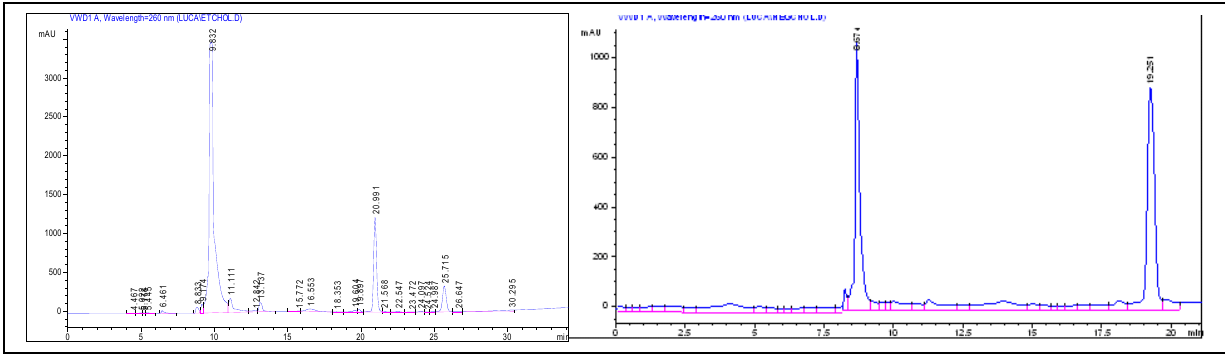
Figure 4. HPLC profiles for the analysis of crude oligomer A (left) and B